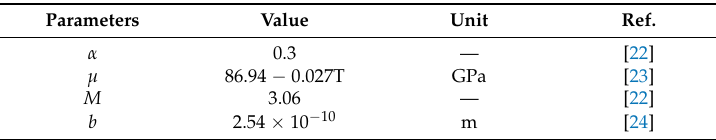
Table 1 . Model parameters. Table 1. Model parameters.